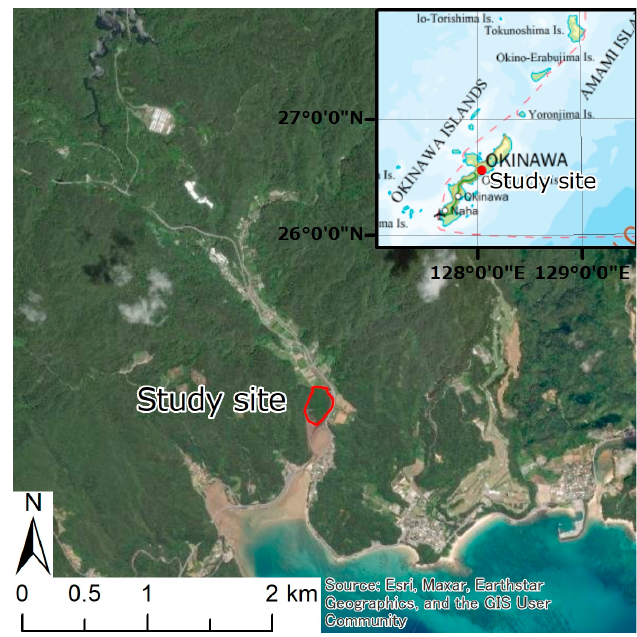
Figure 1. Study location.